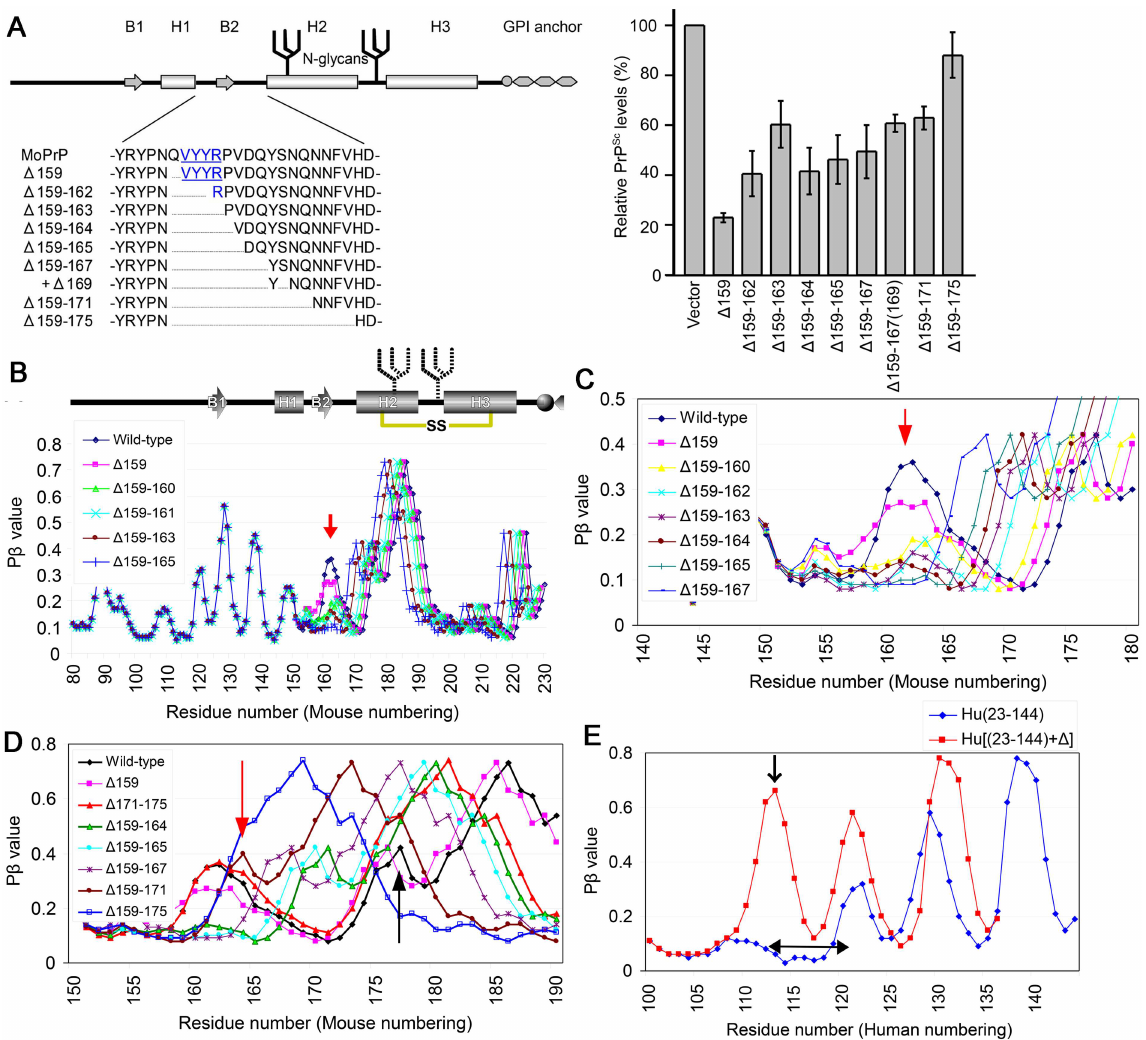
Fig 2. Biological relevanceof P β : heights of P β peaks correlate with dominant-negative inhibition of Δ PrP-series mutants. A . ( Left panel ) Schematicillustrationof mutant PrP with deletions in the regionbetweenH1 and H2 ( Δ PrP-series); ( right panel ), graph showingthe PrP Sc levels of convertible PrP coexisting with the indicatednon-convertible Δ PrP mutant on 22L-infected N2a cells (adaptedfrom reference [13]). The PrP Sc levels of convertible PrP increasedas the size of the deletionof the co-existing Δ PrP increased, indicating that the dominant-negative inhibitory effects of non-convertible Δ PrP on co-existingconvertible PrP are decreased as the size of the deletionincreased. MoPrP, wild-typemouse PrP. B . P β graphsof wild-typemouse PrP and Δ PrP mutants. The height of the peak aroundresidue 160 graduallydecreasedas the size of the deletionincreased(red arrow), but had little effect on the appearancesof the rest of the P β graphs. C . P β graphs of wild-typemouse PrP and Δ PrP mutants, focusingon the regionfrom residue 140 to residue 180, showingthe reductionof the peak more clearly. D . P β graphs of wild-typemouse PrP and Δ PrP mutants, focusingon the regionfrom residue 150 to 190, specificallyon the peak aroundresidue 175 (black arrow). The peak became narrower in Δ 159–171 (red arrow) and finally disappearedin Δ 159–175(blue curve with open squares). E . P β graphsof C- terminally-truncated human PrP (Hu23–144) and a deletion variant of the truncatedmutant Hu23–144+ Δ , with an internaldeletionof residues 113–120(left-right arrow) [14]. The latter protein containedanother large peak